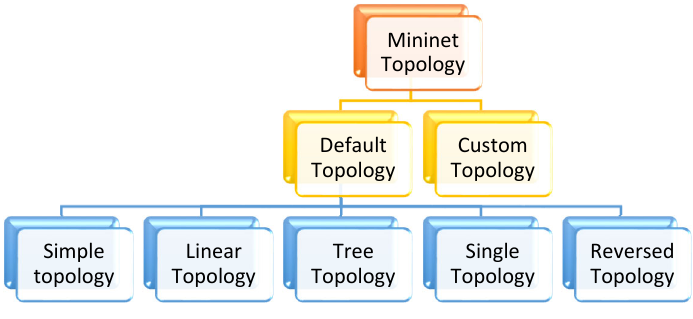
Figure 13. Mininet Types.